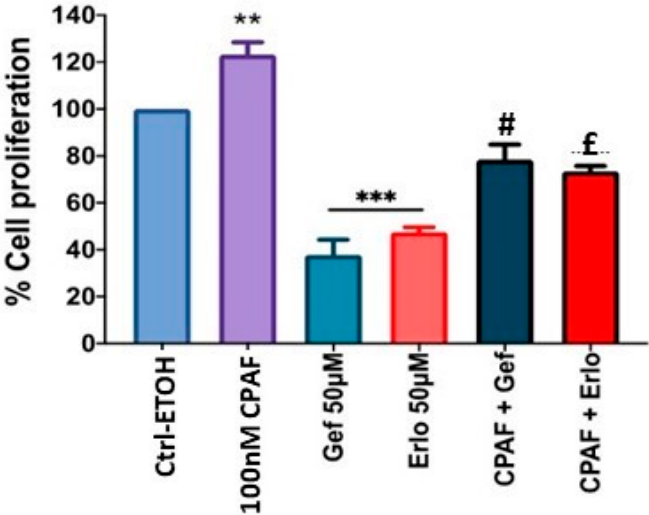
and/or cytotoxic responses of targeted therapies is shown as Figure 9.